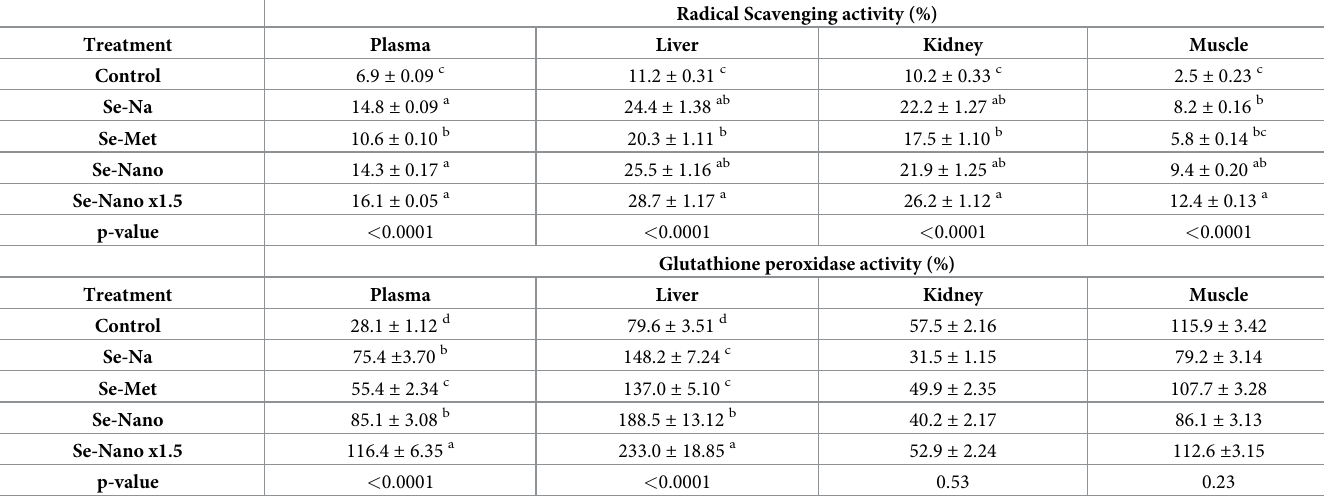
Table 4. Antioxidant activity and glutathione peroxidase activity of different fish tissue from Nile tilapia ( Oreochromis niloticus ) fed with different dietary selenium sources over a 60-day